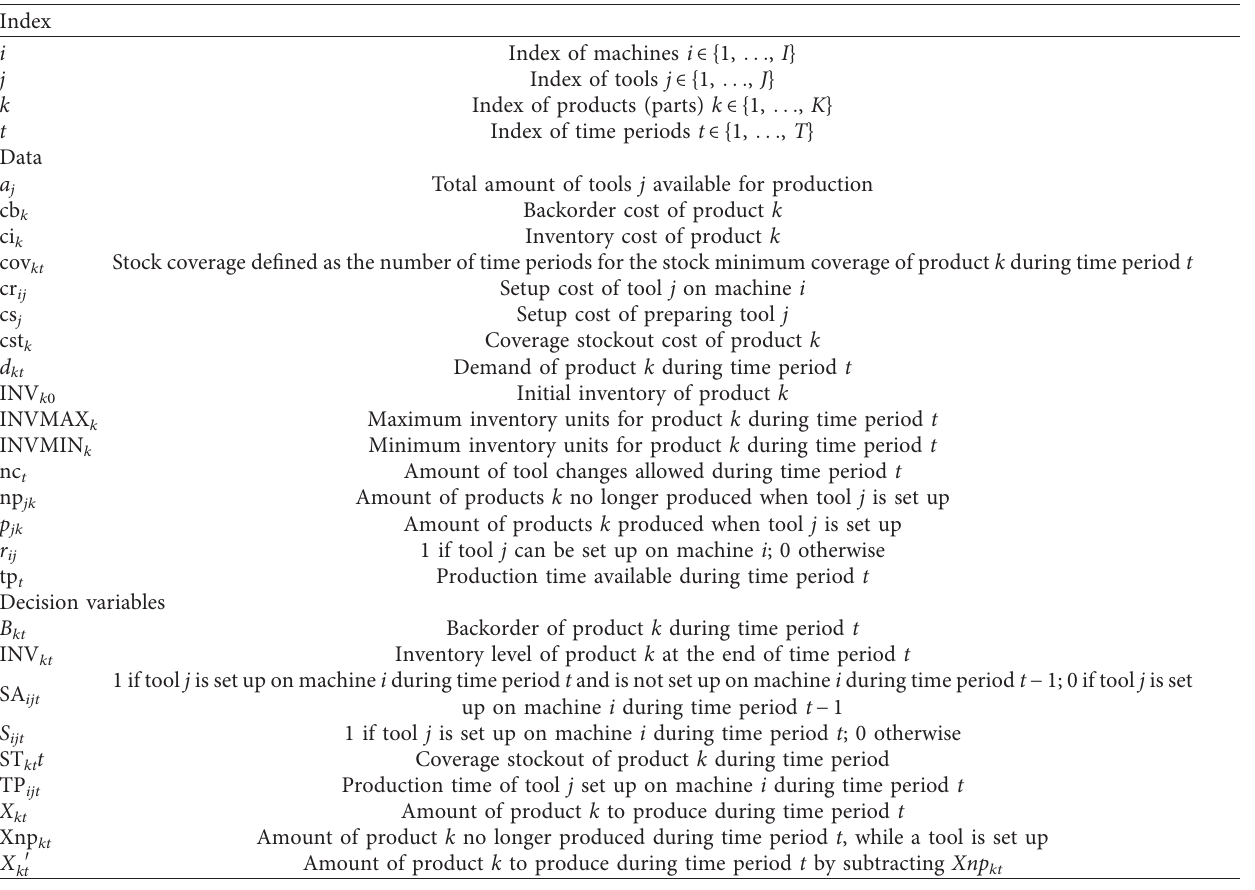
Table 2: Nomenclature for the